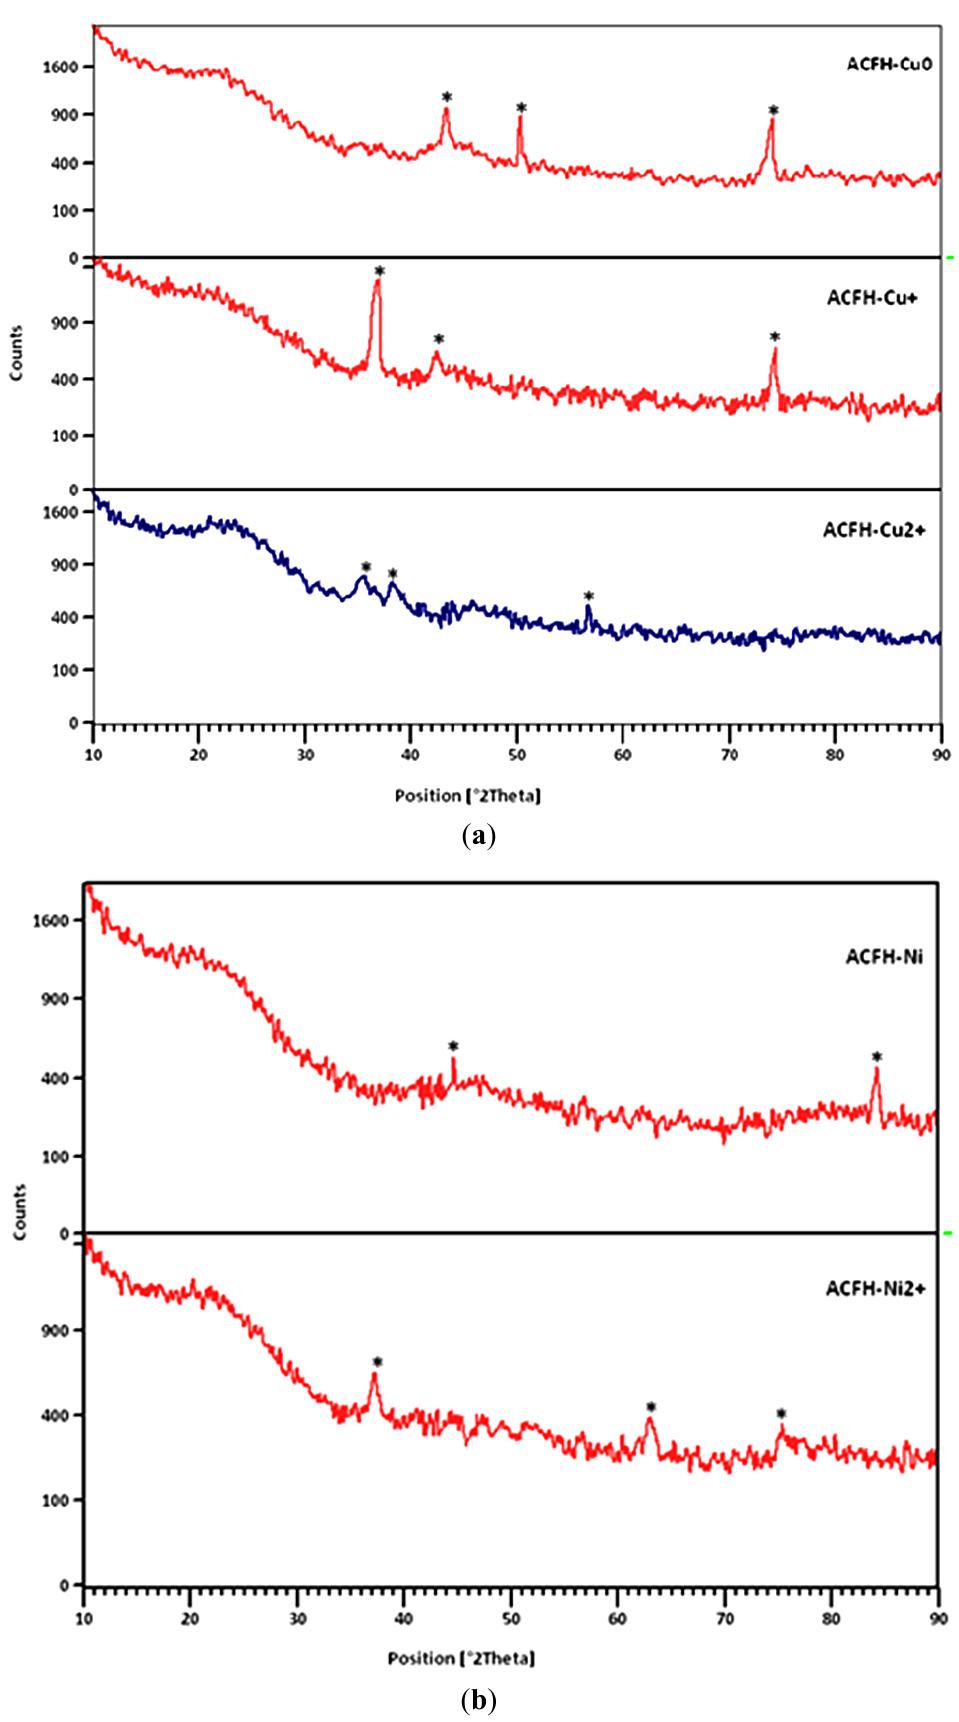
Figure 1. XRD patterns of ( a ) copper- and ( b ) nickel-impregnated ACFH